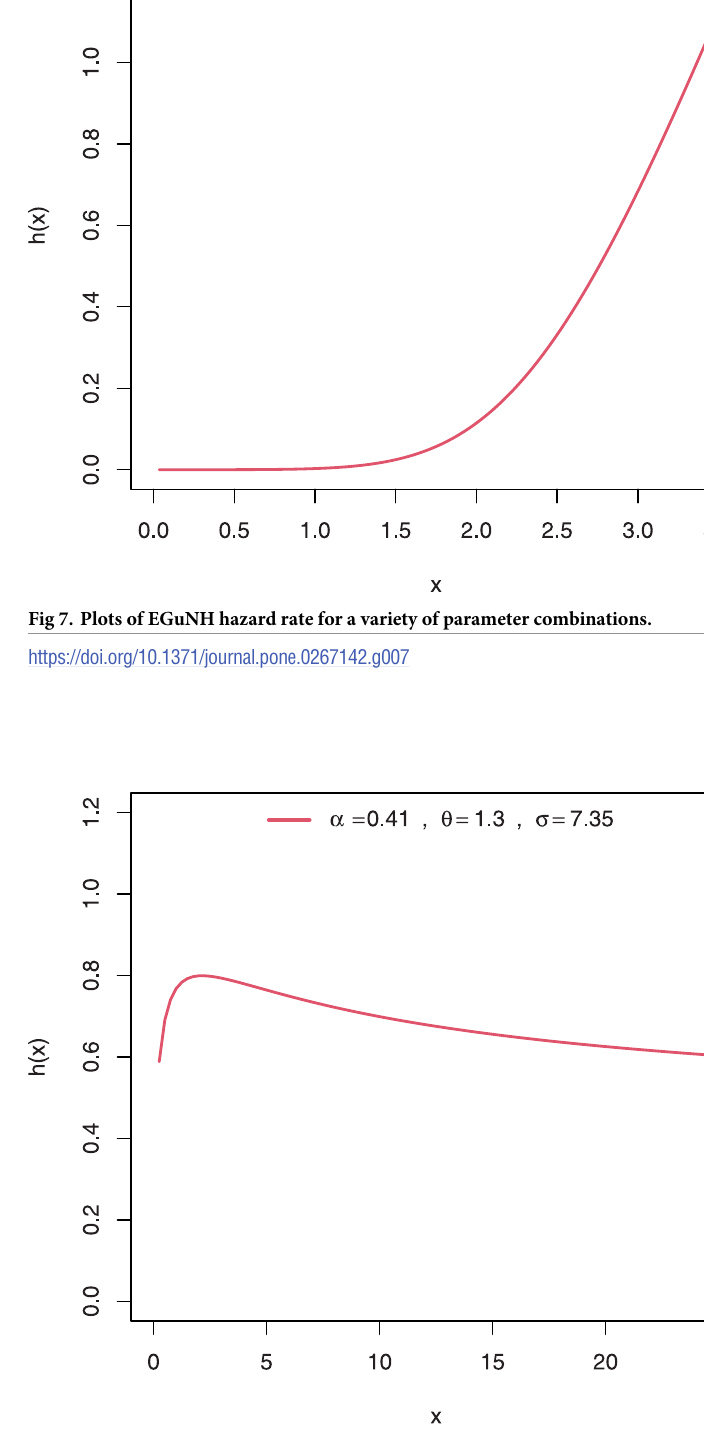
Fig 8. Plots of EGuNH hazard rate for a variety of parameter combinations.